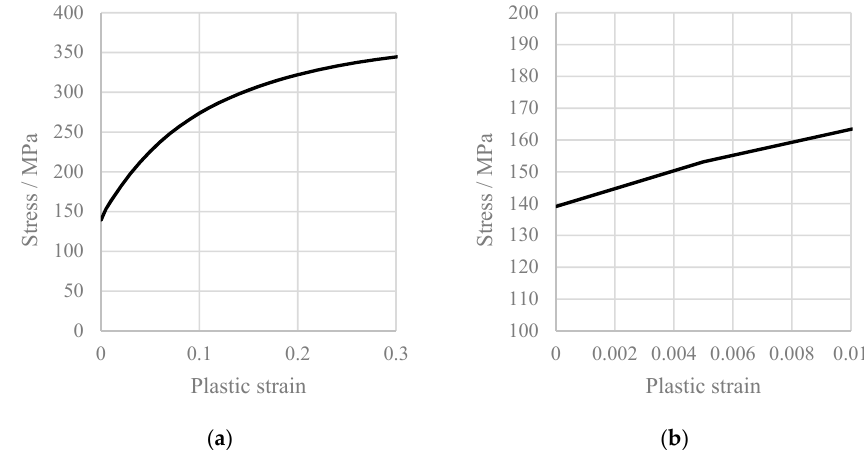
Figure 4. Stress-strain curve under uniaxial stress in the 0° direction ( a ), Zoomed S-S curve ( b ).